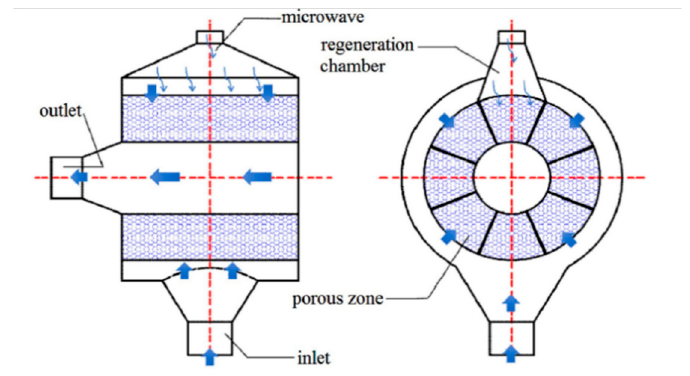
Figure 8. Schematic diagram of a rotary DPF